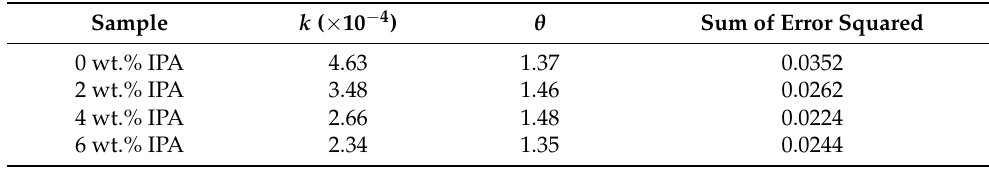
Table 1. Maximum lap shear stress of adhesive samples containing 0, 2, 4, and 6 wt.% IPA. Sample Type/Sample